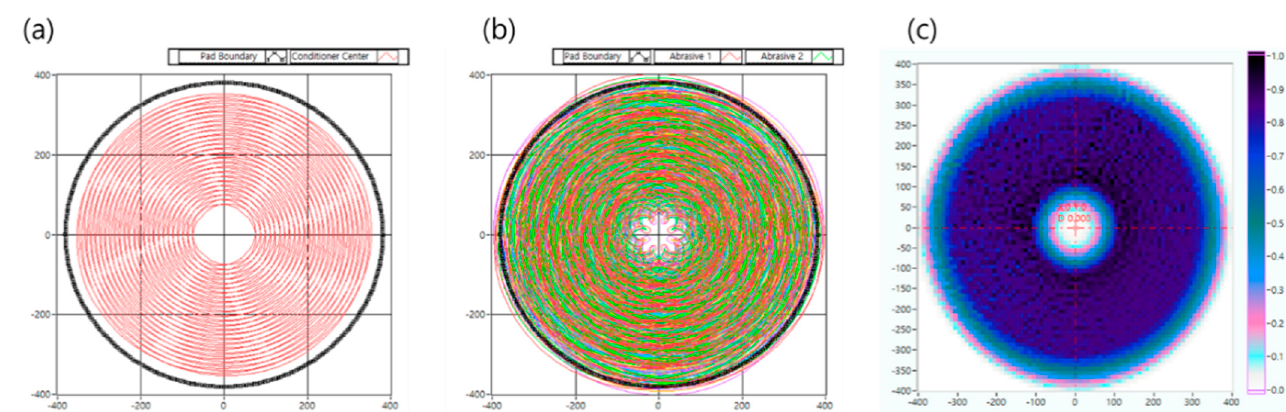
Figure 5. ( a ) Disc-centered motion trajectory predicted by the developed simulation; ( b ) Trajectory of all working diamond abrasives; ( c ) Color contour through integration of the trajectory length.